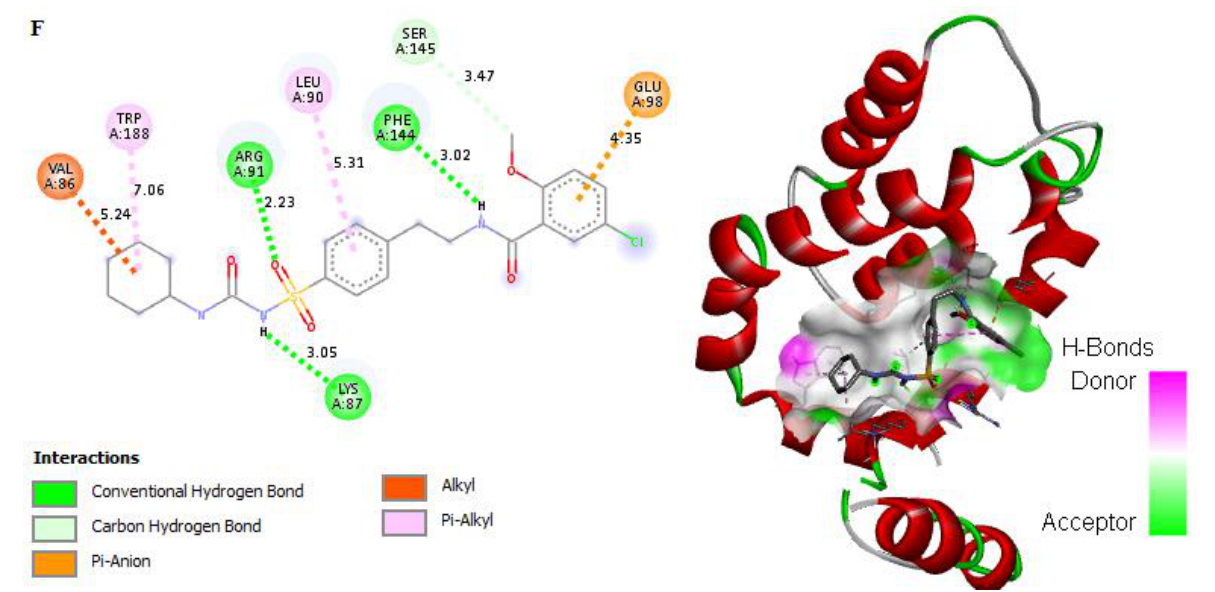
Figure 8. In silico docking and binding interactions of HSP and GB with NF- κB, cleaved caspase-3, and BCL2 markers showing the analysis of amino-acid interactions and their length, together with the binding pocket of ligand – receptor interactions for ( A ) HSP and NF- κB , ( B ) GB and NF- κB , ( C ) HSP and cleaved caspase-3, ( D ) GB and cleaved caspase-3, ( E ) HSP and BCL2, and ( F ) GB and BCL2. HSP, hesperidin; GB, glibenclamide; NF- κ B, nuclear factor kappa-light-chain-enhancer of activated B cells; cleaved caspase-3, cysteine aspartic protease-3; BCL2, B-cell lymphoma 2. 2.10. Effect of HSP on Cell Viability and Glucose Uptake of 3T3-L1 Cell